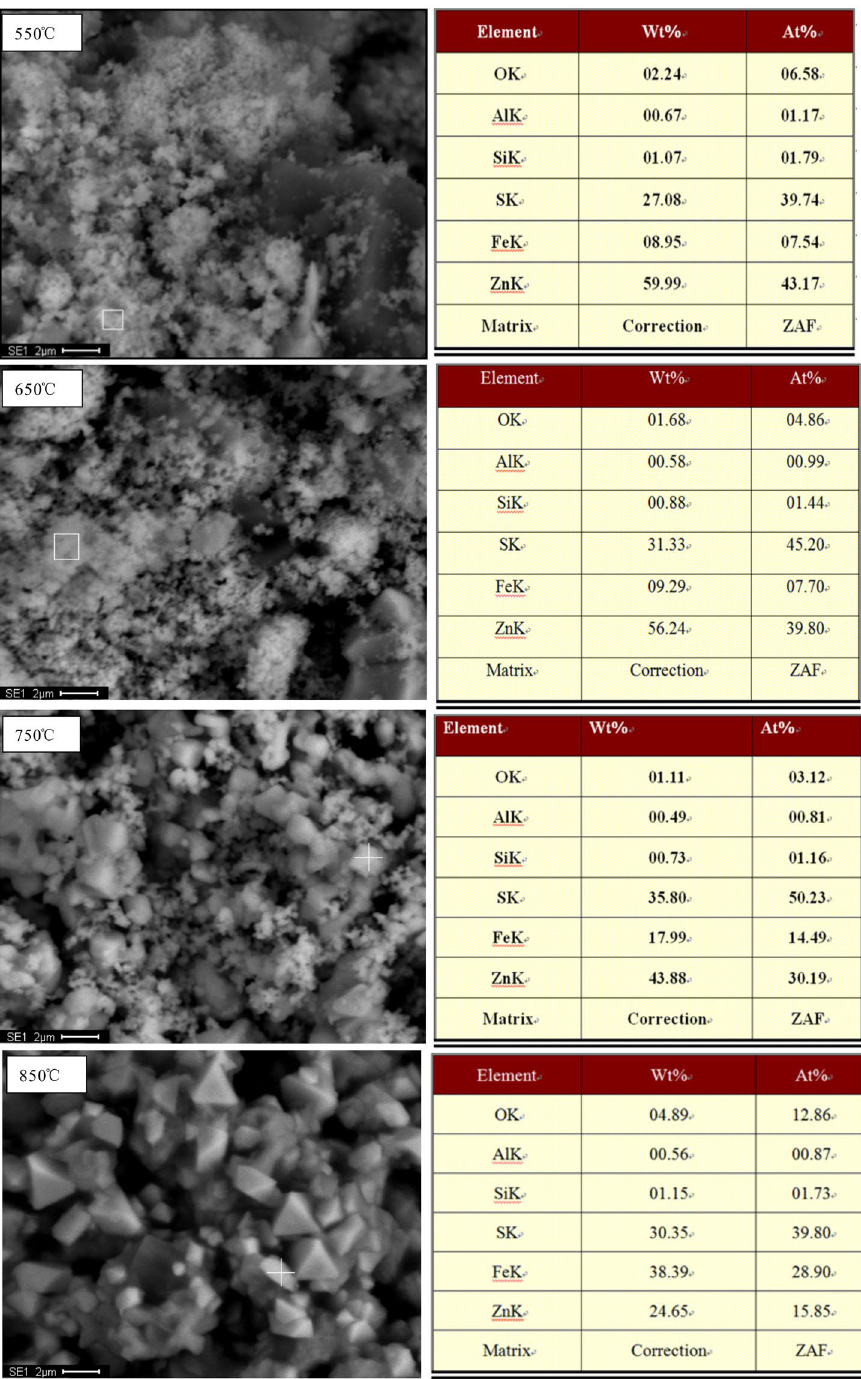
Figure 7. BSE images and EDS spectrums of the roasted products at different